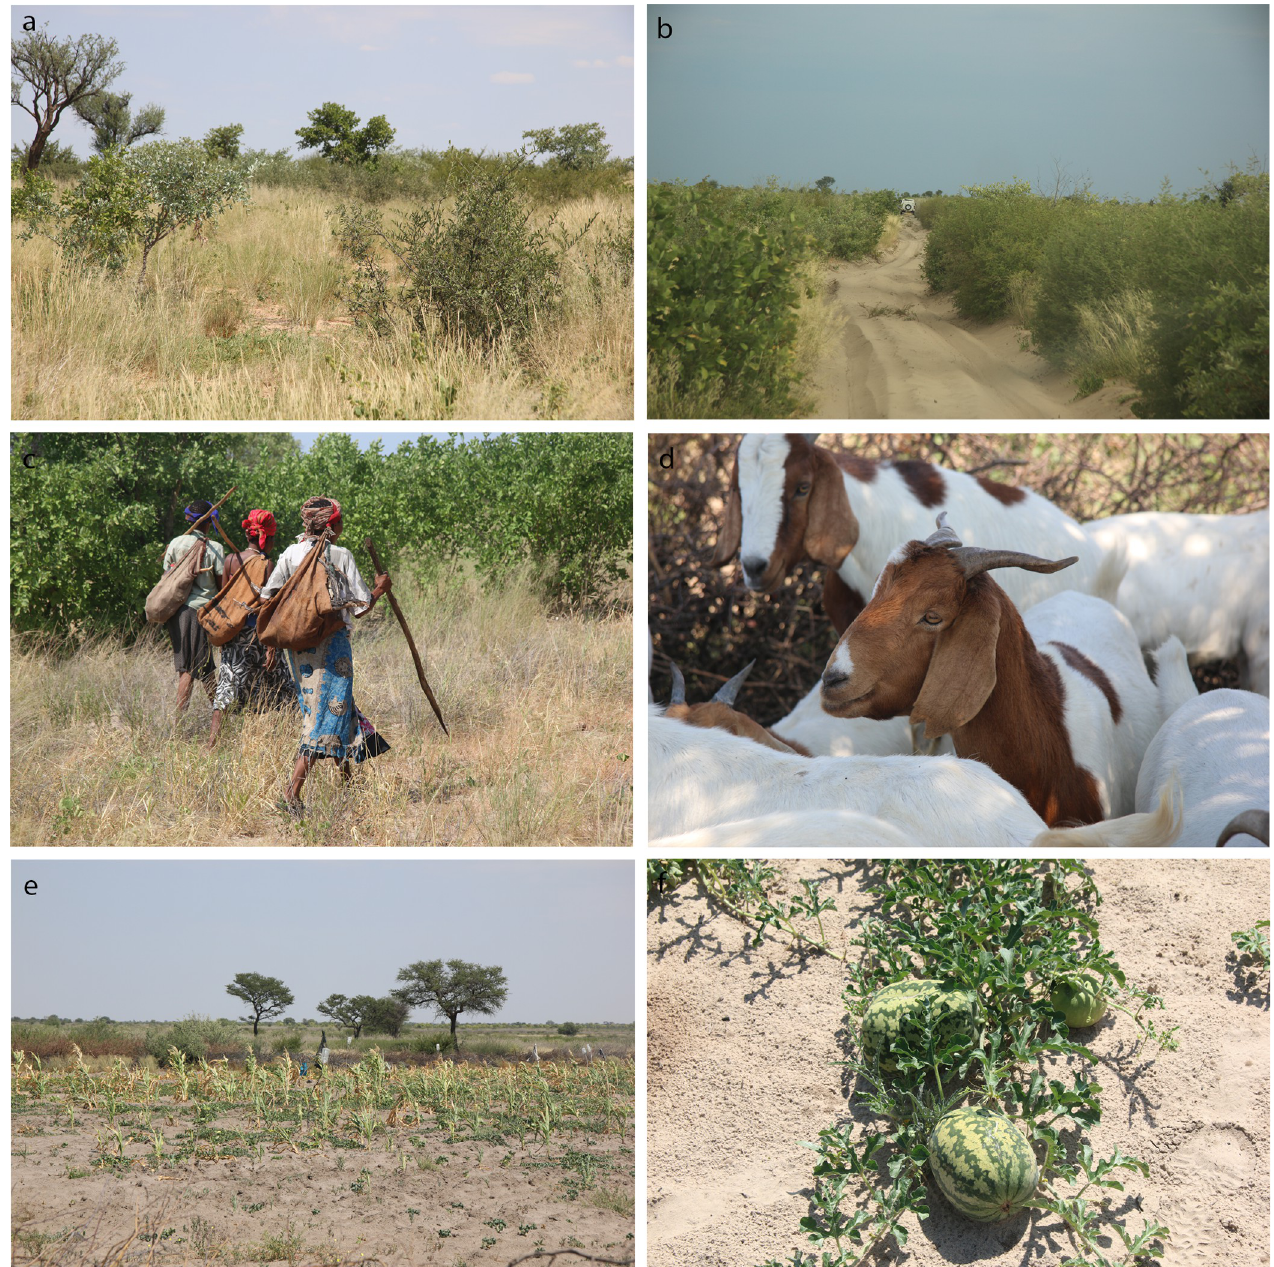
Fig 4. Central Kalahari Game Reserve (CKGR), Botswana. a. Arid savanna near Gope. b. Molapo-Metsiamonong track with deep sand. c. Arid bush savanna near Metsiamonong, with G/ui and G//ana women gathering food (note the kaross , animal hide carriers). (d–f) G/ui and G//ana livestock and crops such as d. goats in a kraal at Gope, e. corn (‘maize’), and f. watermelon (photos: T.L. Bird).